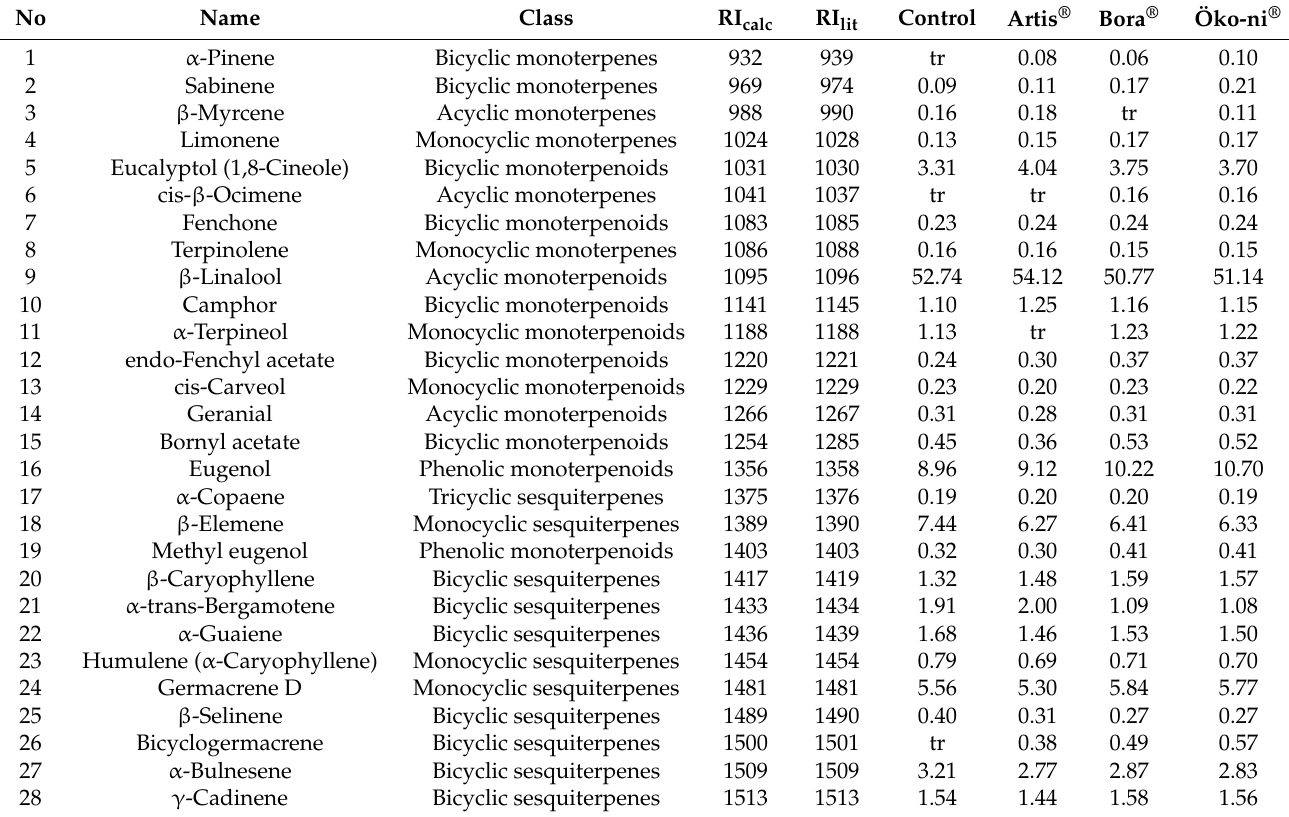
Table 5. Influence of myco-biocontrol formulates on essential oil composition of